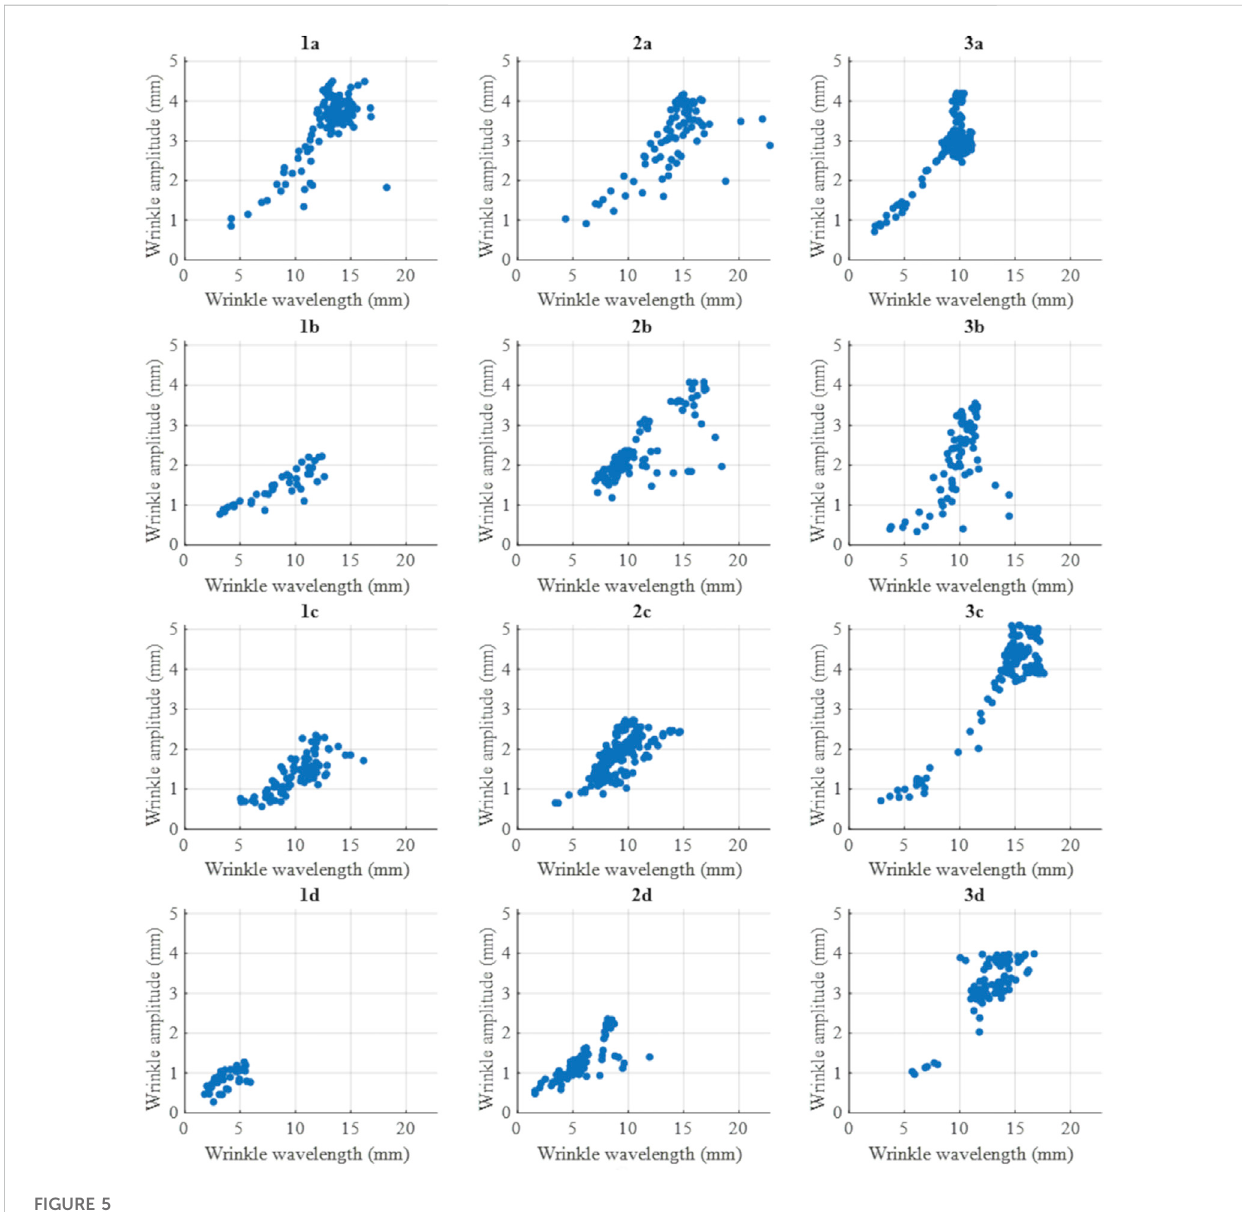
FIGURE 5 Wrinkle amplitude vs. wavelength